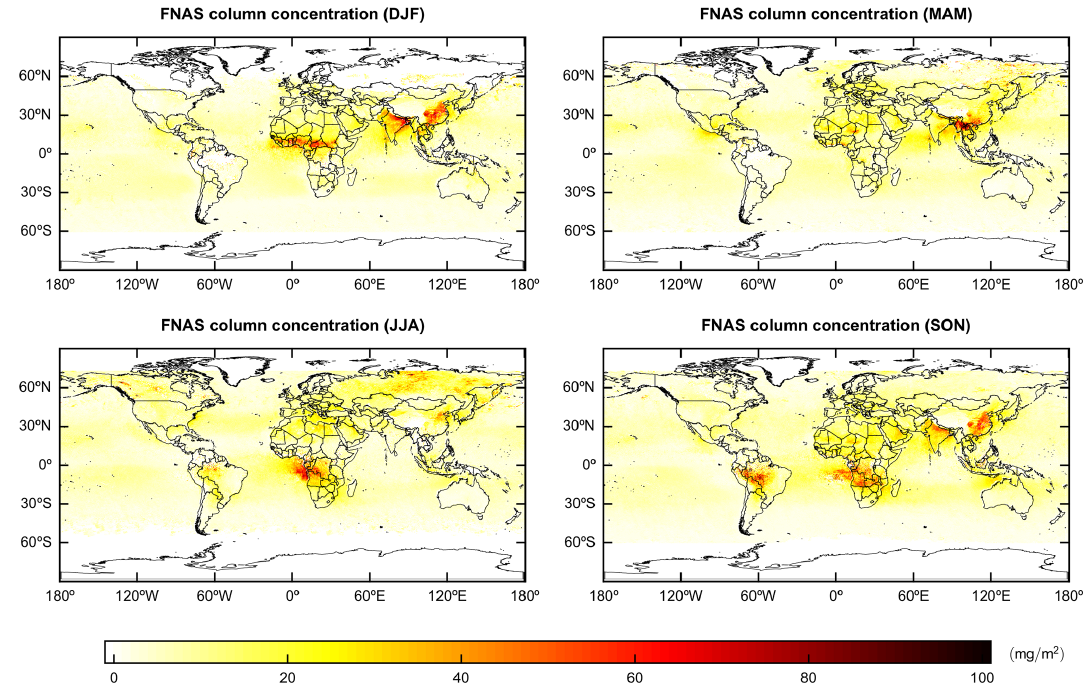
Figure 17. Spatial distribution of seasonal fine-mode non-absorbing soluble (FNAS) component column mass concentration (mgm 2 ) derived from POLDER-3 observations using the GRASP/Component approach. December–January–February (DJF); March–April–May (MAM); June–July–August (JJA); September–October–November (SON).